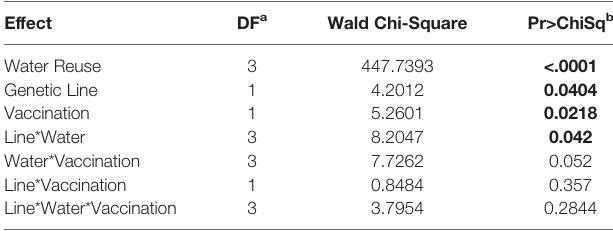
TABLE 2 | Signi fi cant effects survival analysis in the fi eld experiment.